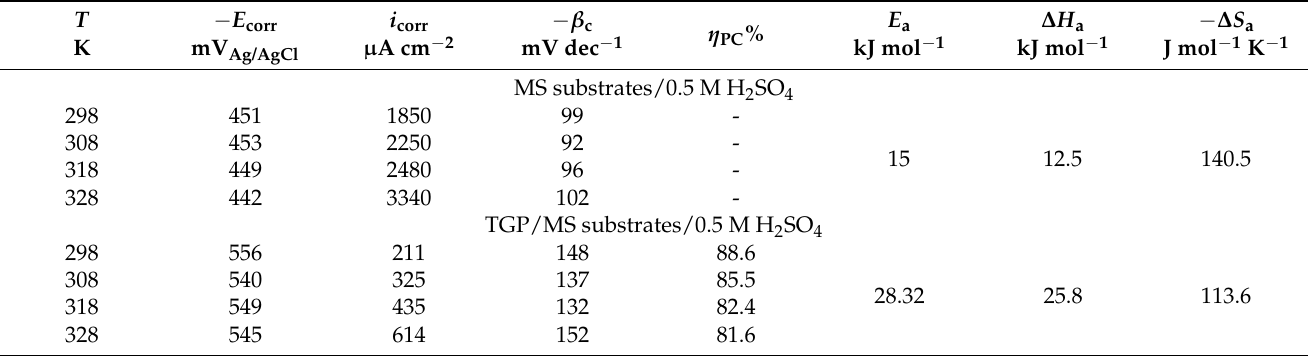
Figure 5. PDP plots of MS uninhibited and inhibited in 0.5 M H 2 SO 4 with inhibitory TGP resin (10 − 3 M) at different temperatures. Table 5. Electrochemical and kinetic parameters of MS uninhibited and inhibited in 0.5M H 2 SO 4 with inhibitory TGP resin (10 − 3 M) at different temperatures.